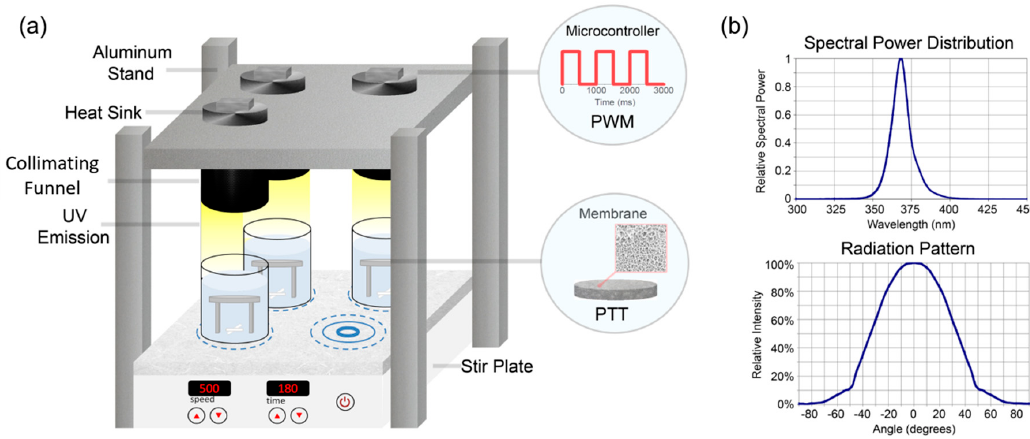
Figure 3. ( a ) Experimental setup for UV/TiO 2 reactors and ( b ) UV-LED spectral power distribution and radiation pattern. Abbreviations: PWM—pulse-width modulation, PTT—porous titanium–titanium dioxide.